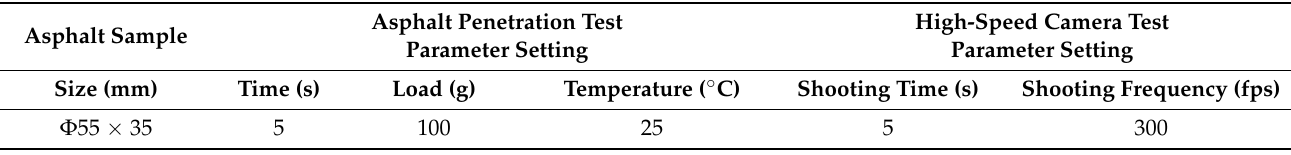
Table 1. Test parameter